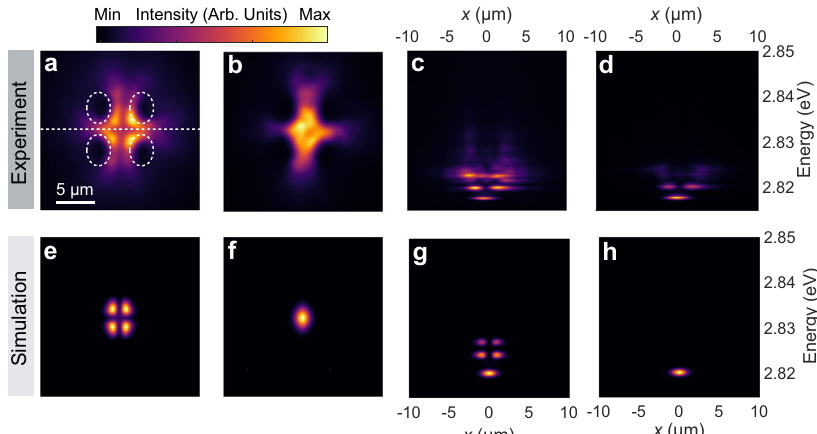
Fig.6|Characterisationofmulti-modecondensatesinatwo-dimensionaltrap. a , b Experimental and e , f , theoretical real-space images of the cavity pumped by fourlaserspotswithcentreslocatedatverticesofasquarewiththeedgeof5 μ mat 4.1 μ W( a , e ),and6.8 μ W( b , f ).Whitedashedellipsesindicatethepositionsofpump